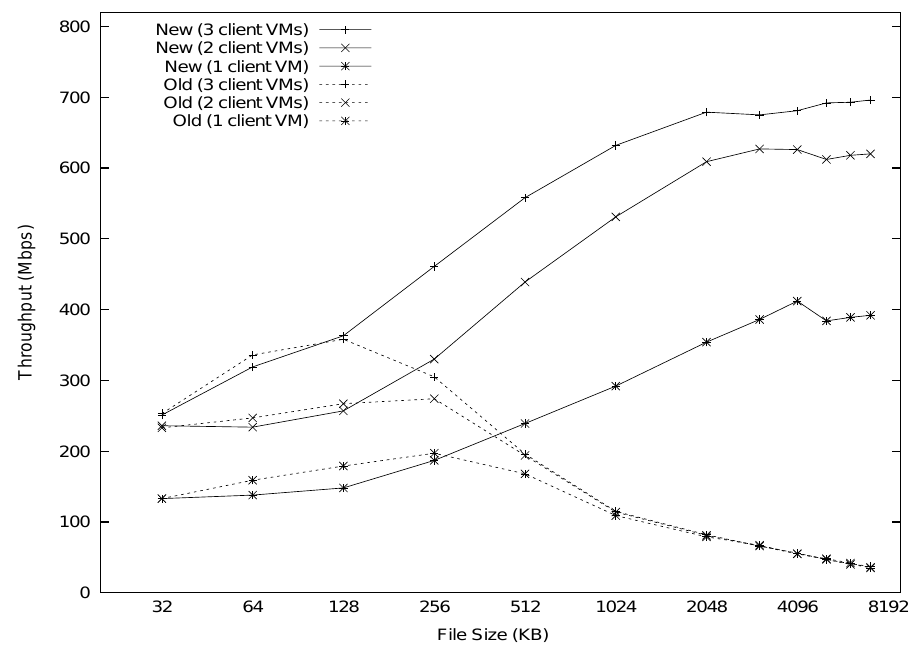
Figure 2. Throughput comparison between original (“Old”) and modified (“New”)